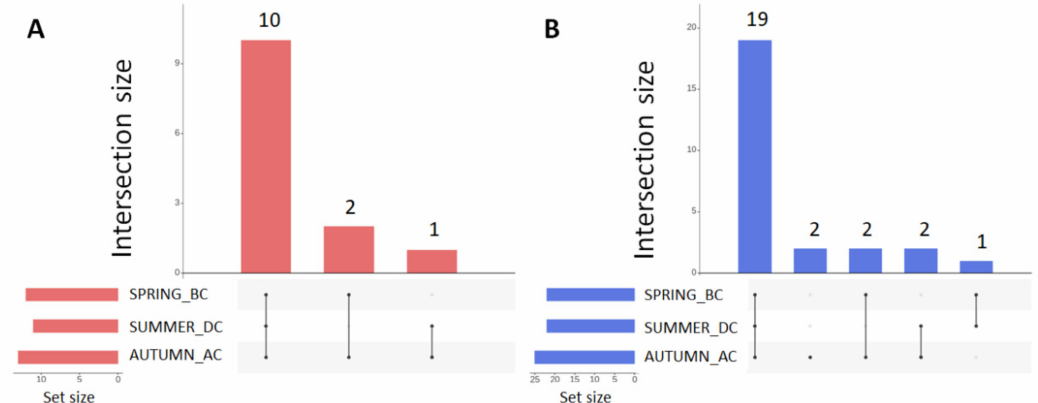
Figure 5. UpSet plots for grouping co-occurring variables based on their frequency at the phylum (red) and class (blue) levels. Frequencies of the detected phyla ( A ) and classes ( B ) among the different seasons (Spring_BC, Summer_DC and Autumn_AC) across all nine field sites.